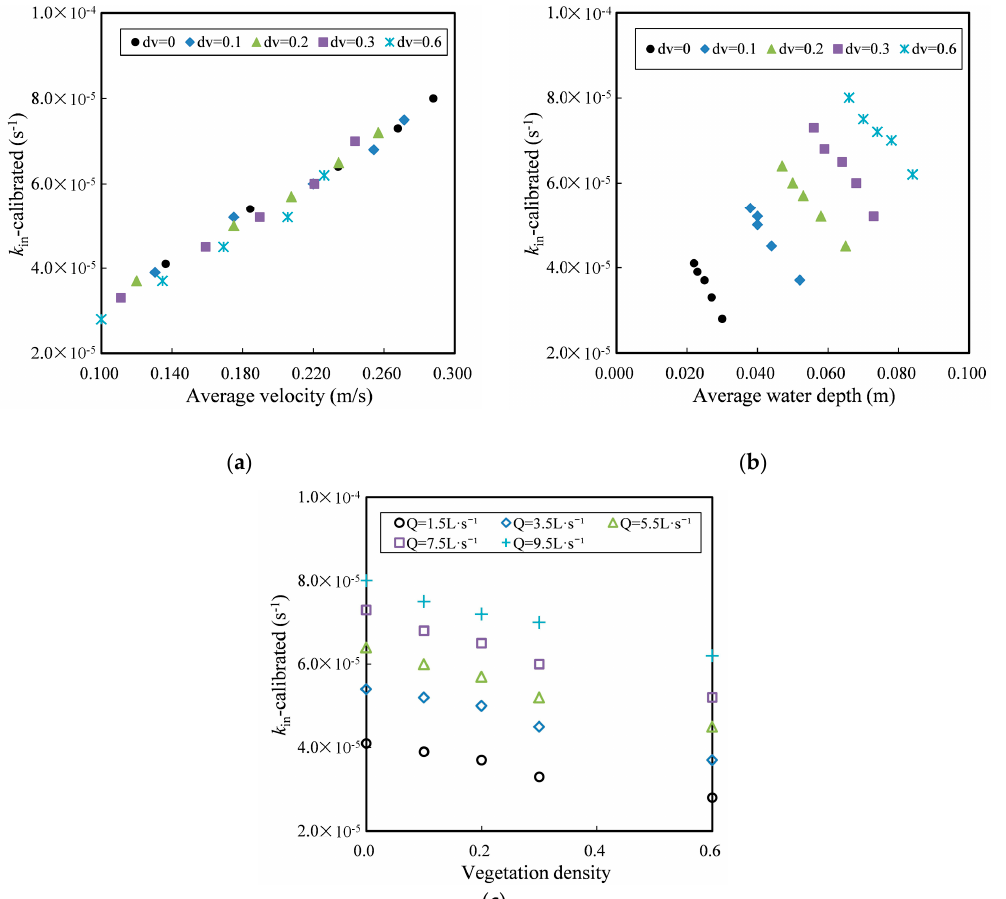
Figure 4. Relationships between the inner dissipation coefficient and various parameters. Table 3. Comparison of the inner dissipation coefficient of supersaturated total dissolved gasbetween calculated results and experimental data.